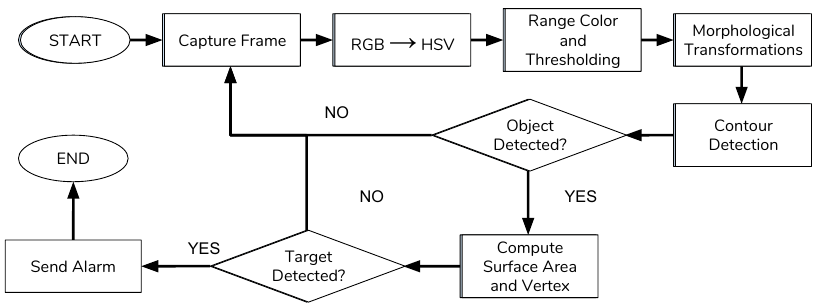
Figure 6. Flowchart for the detection